Question: Write the caption for this figure.
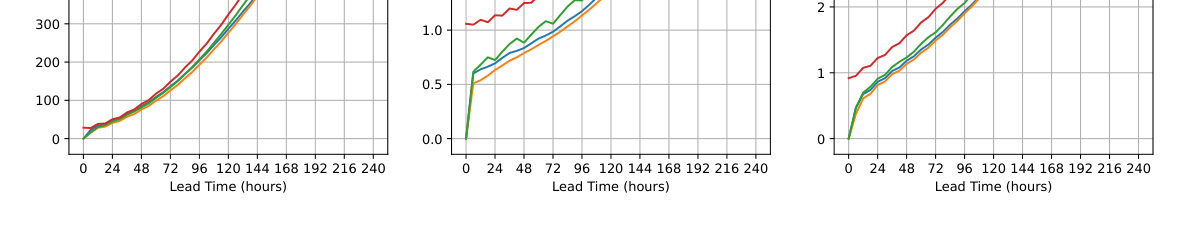
Answer: Weatherbench 2 deterministic RMSE comparison of forecasts of z500, t2m, and u10m at lead times up to 10 days for the swin model using channel-weighting, 8-step fine-tuning, and latitude-weighted loss, IFS HRES, Pangu-Weather, and Graphcast compared to climatology.